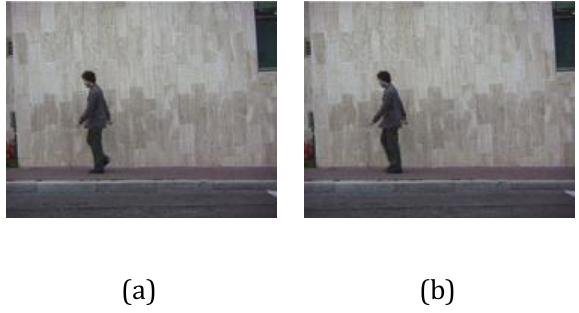
Figure 9. Abnormal “Walk” actions. ( a , b ) Misclassification examples.